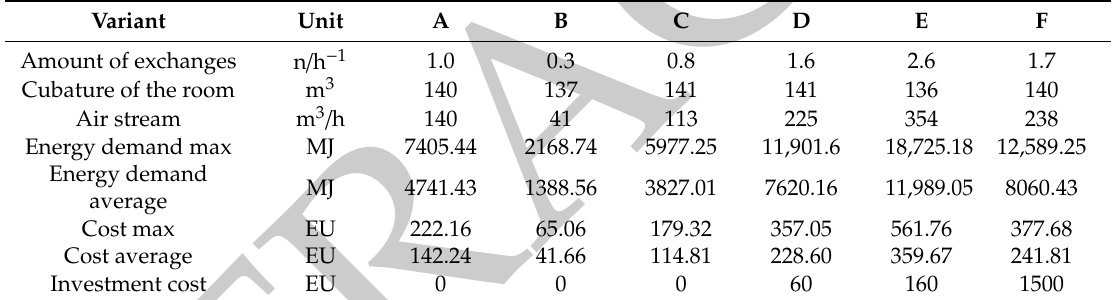
Table 2. The cost of heating the air stream for the analyzed school.